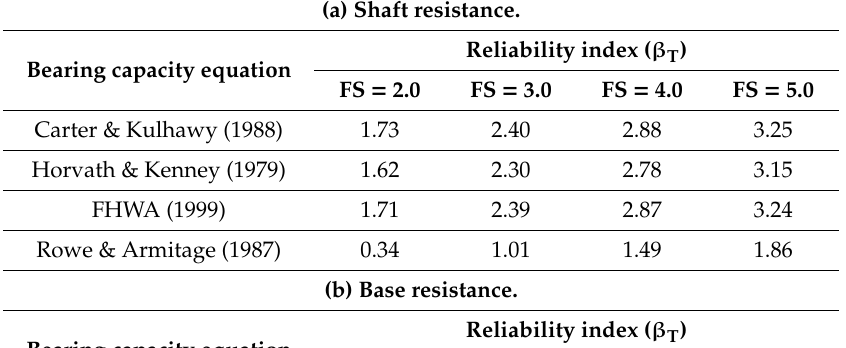
Table 10. Reliability analysis